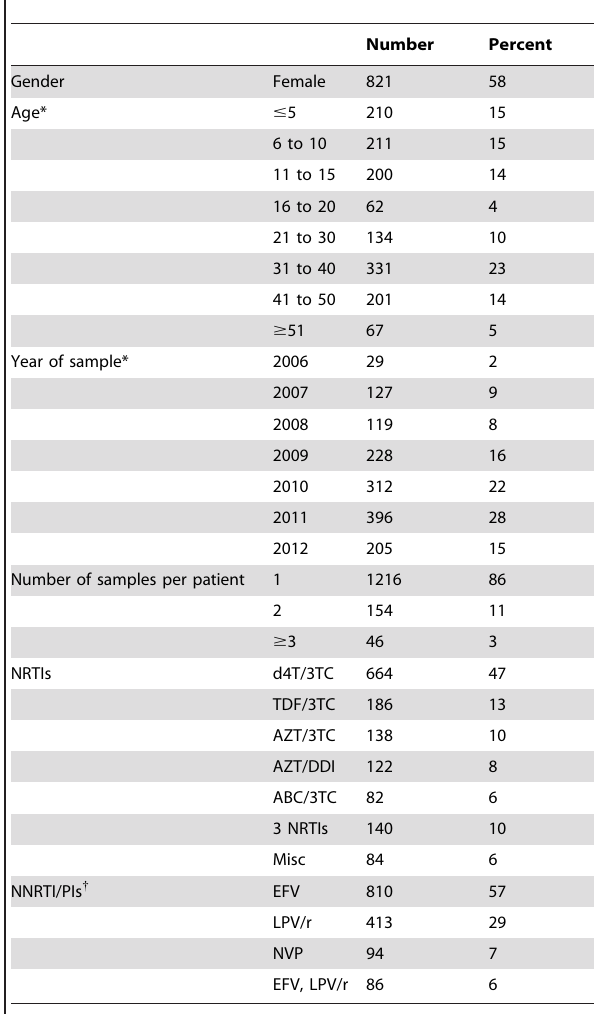
Table 2. Demographic and Antiretroviral Treatments of 1,416 Patients Undergoing HIV-1 Genotypic Resistance